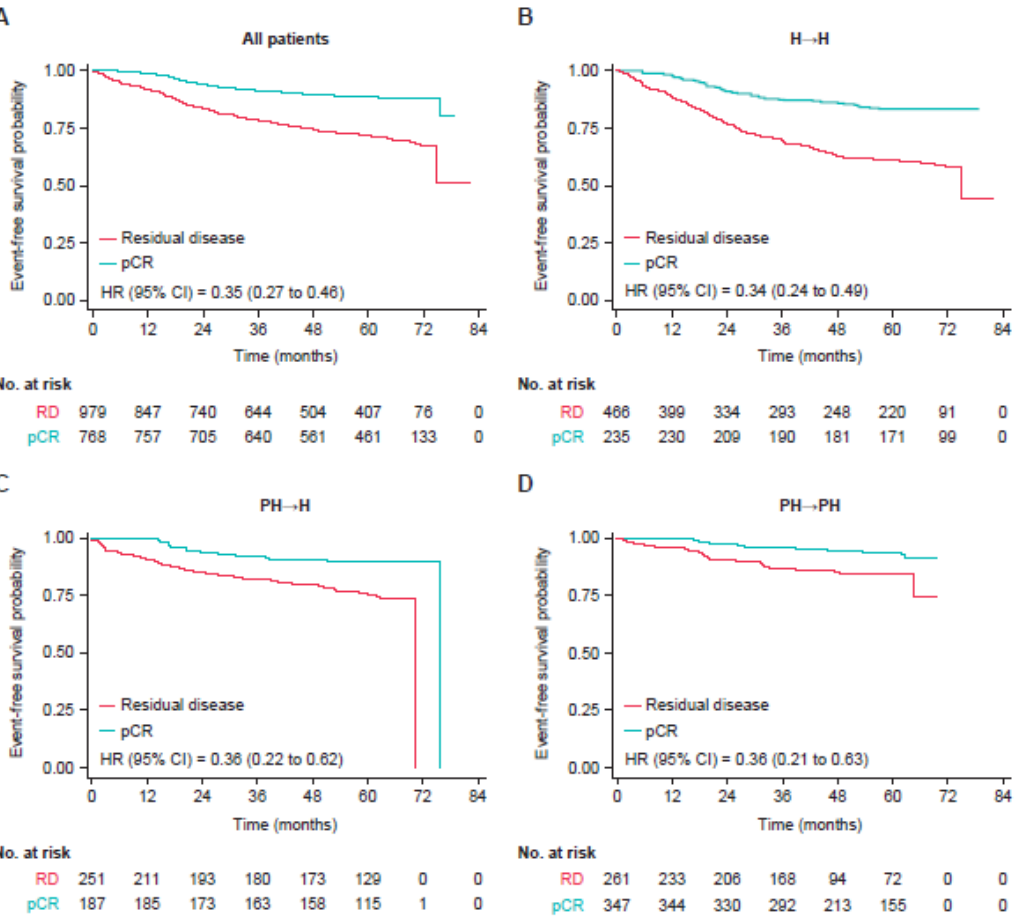
Table 3. Treatment effect by pathological complete response and treatment modality using inverse probability of treatment weighting analysis *.